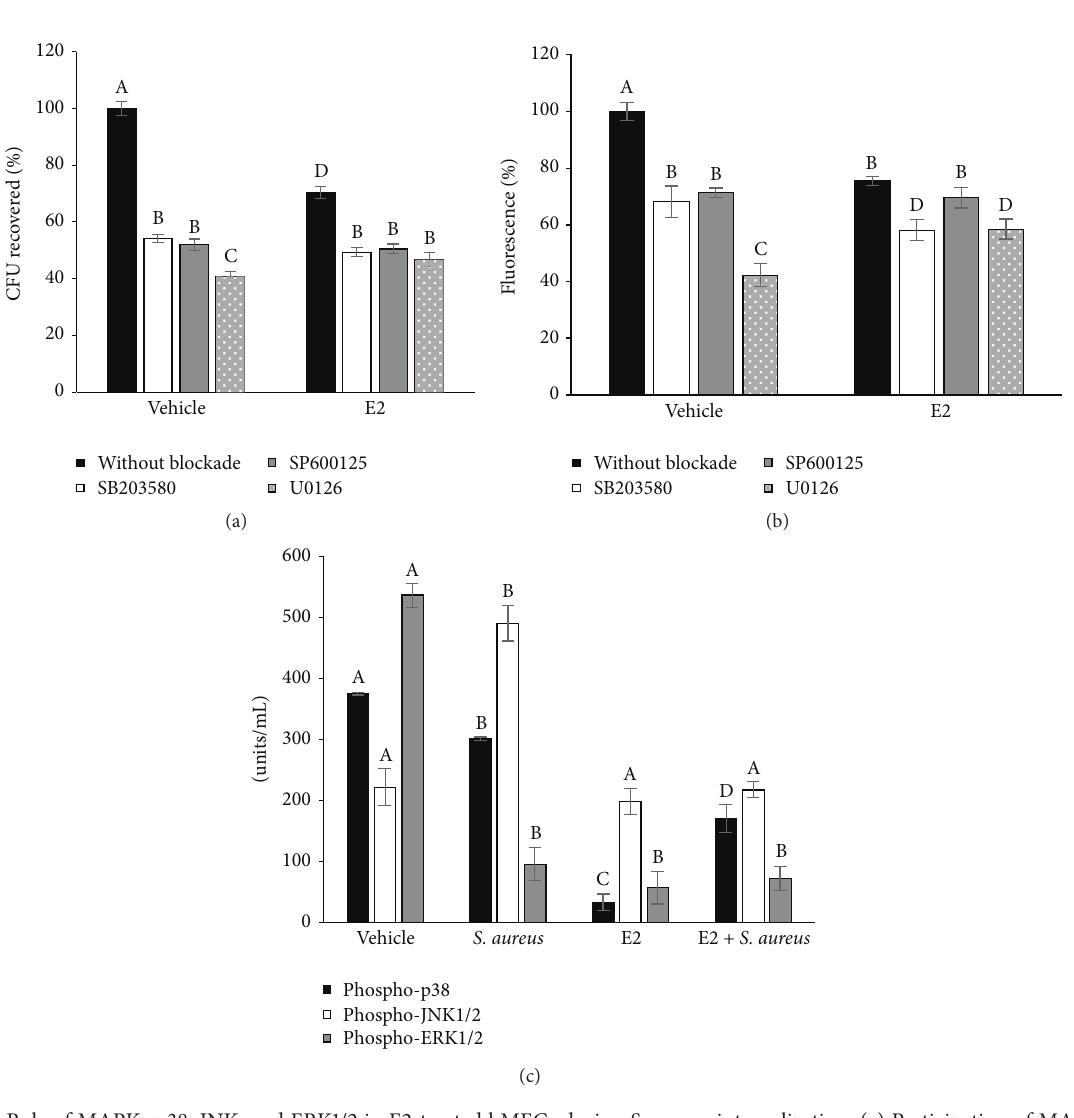
Figure 5: Role of MAPKs p38, JNK, and ERK1/2 in E2-treated bMECs during S. aureus internalization. (a) Participation of MAPKs in S. aureus internalization determined by CFU units. bMECs were incubated (30 min, 1 or 2 h) with pharmacological inhibitors of p38 (5 𝜇 M, SB203580), JNK (20 𝜇 M, SP600125), or ERK1/2 (2.5 𝜇 M, U0126) prior to infection with S. aureus (2h). Values were determined considering the control (bMECs cultured with the vehicle 1% ethanol) as 100% internalization. (b) The same procedure was used to determine S. aureus internalization by flow cytometry using the LIVE/DEAD BacLight Bacterial viability kit. Fluorescence intensity was estimated from 10,000 events. (c) Phosphorylation was measured in bMECs that were treated with 50 pg/mL E2 and/or challenged with S. aureus by flow cytometry. The phosphorylated MAPK concentrations (U/mL) are represented: (a) pp38, (b) pJNK, and (c) pERK1/2. SB203580: p38 inhibitor. SP600125: JNK1/2 inhibitor. U0126: ERK1/2 inhibitor. According to manufacturer’s protocol 300 events were obtained. In (a) and (b) different letters indicate significant changes among treatments ( 𝑃 < 0.05 ), and in (c) different letters above the bars indicate significant changes among the four treatments within the same MAPK evaluated ( 𝑃 < 0.05 ). Vehicle: 1%